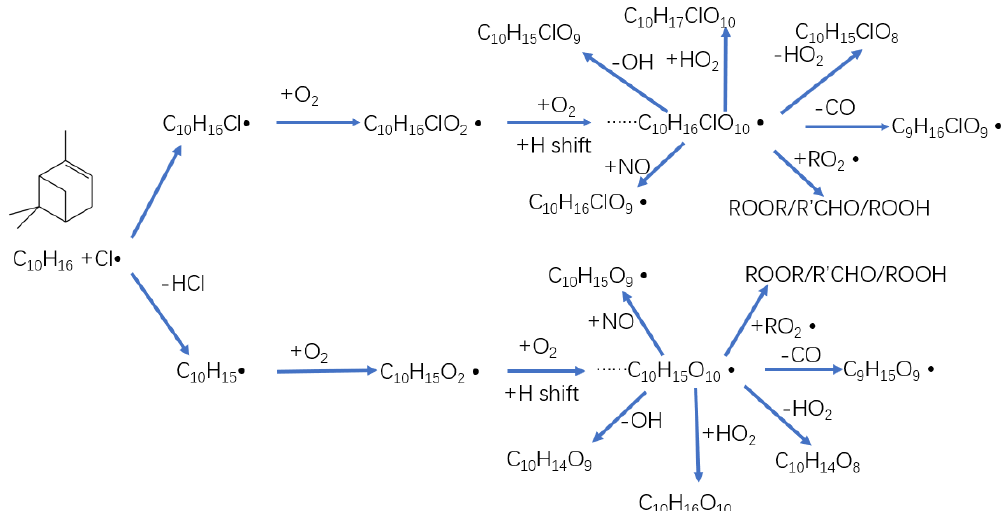
Figure 5. Proposed chemical pathways for chlorine radical oxidation of alpha-pinene and subsequent autoxidation and HOM formation. The upper path shows the chlorine radical addition pathway, while the lower chain shows hydrogen atom abstraction pathway. In both cases, initially a C-centred radical forms (C 10 H 16 Cl or C 10 H 15 ) to which O 2 is added to form an initial peroxy radical. This peroxy radical may then undergo multi-step autoxidation to reach the example molecules C 10 H 16 ClO 10 or C 10 H 15 O 10 before